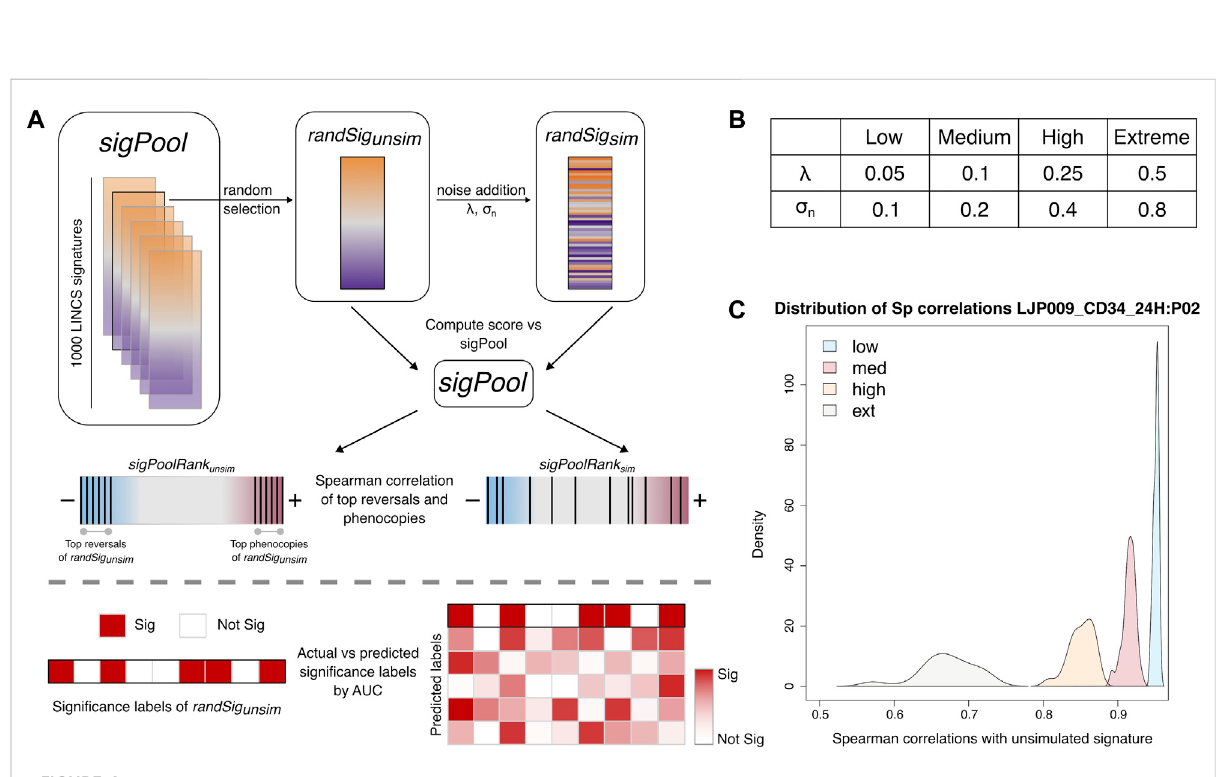
FIGURE 4 Simulation ofnoiseindifferentialexpression. (A) Schematicofnoiseadditionandanalysesofthenoisysignatures. (B) Parameters usedfornoise simulation. (C) Representative density plots of Spearman correlations between simulated and unsimulated randSig at each noise level ( n =